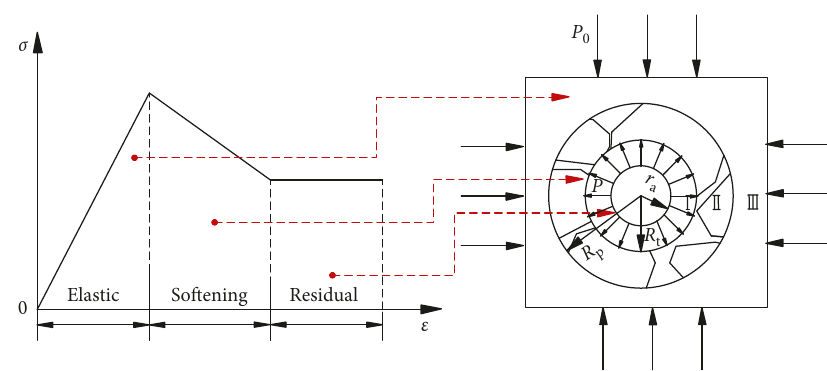
Figure 3: Mechanical model of borehole